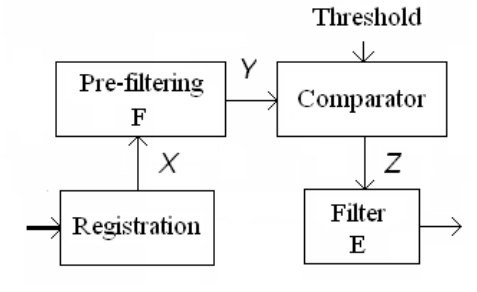
Figure 3. Image processing structure for objects